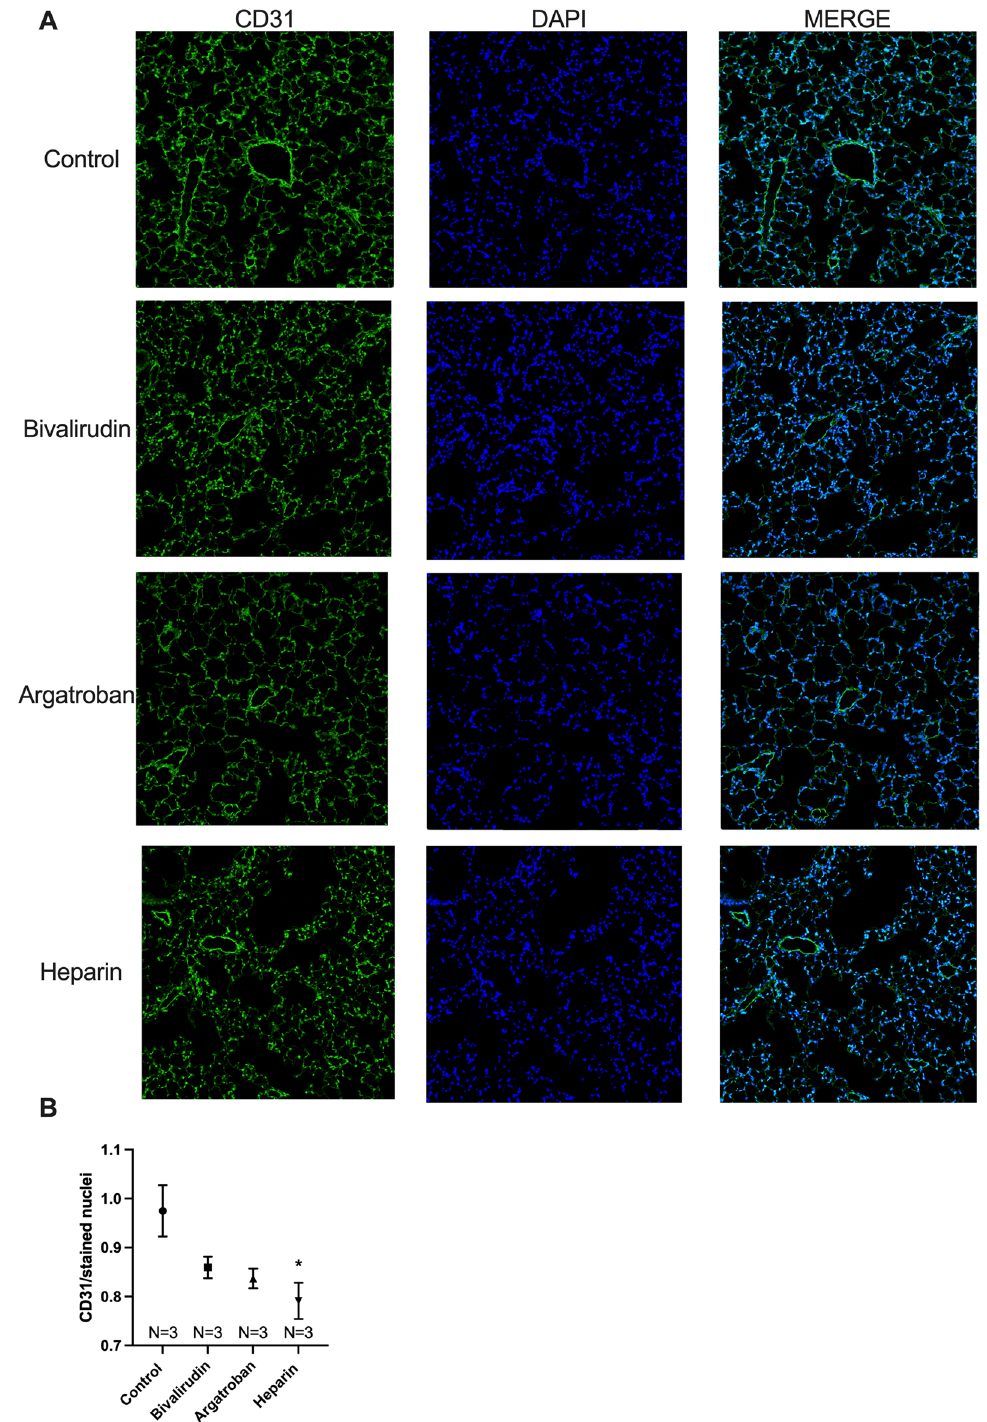
Figure 4. Immunohistochemistry. Representative micrographs at 200 × magnification of co-stained lung tissue for the endothelial cell marker CD31 (green) and nuclear marker DAPI (blue) at postoperative day 8 following left pneumonectomy ( A ). Based on quantification, CD31 was decreased in heparin-treated mice compared to controls ( B ). There was no significant difference in CD31 staining in the bivalirudin or argatroban groups. Statistical analysis of the experimental groups was done using analysis of variance (ANOVA), with Dunnett’s adjustment for multiple comparisons. Shown are mean ± standard error. * P <